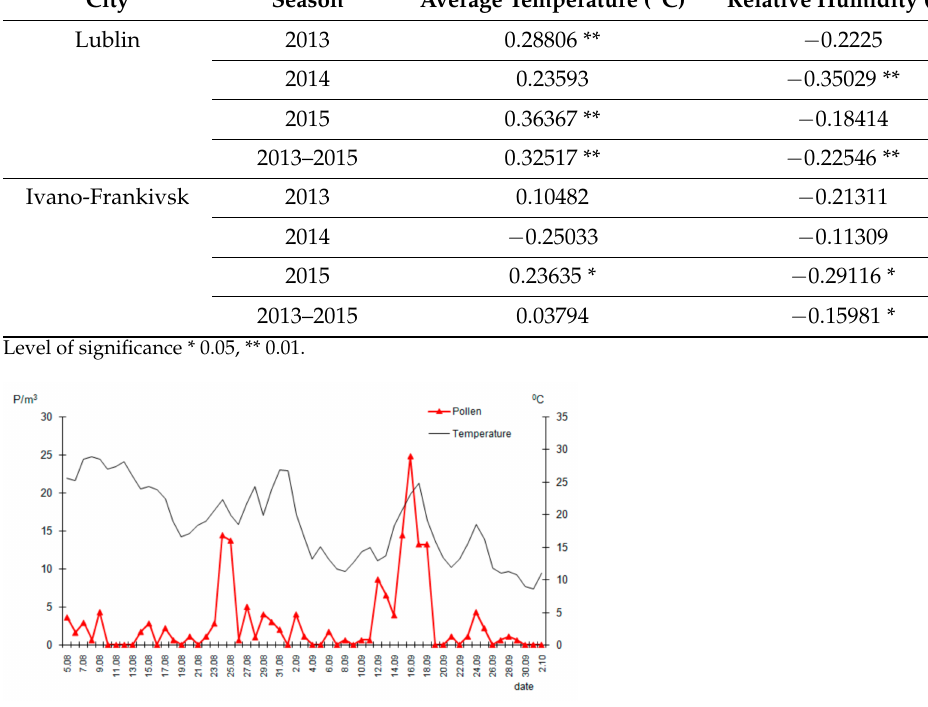
Figure 6. Course of the Ambrosia pollen season in Lublin in 2015 versus the mean air temperature. The influence of other weather parameters on the pollen concentration was inves- tigated in Lublin. The statistical analysis showed that the cloud cover and wind speed had no significant effect on the concentration of Ambrosia pollen in the air, whereas a relationship with precipitation was found (at the level of 0.05) only in 2013 (R = 0.20965) and 2014 (R =